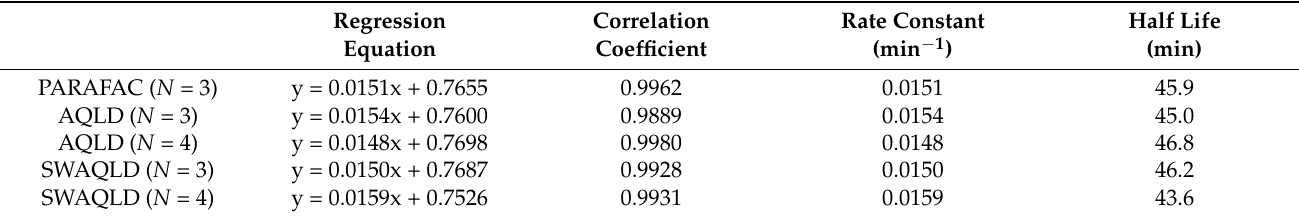
Table 6. Evaluation of the FLU rate constant considering different approaches and